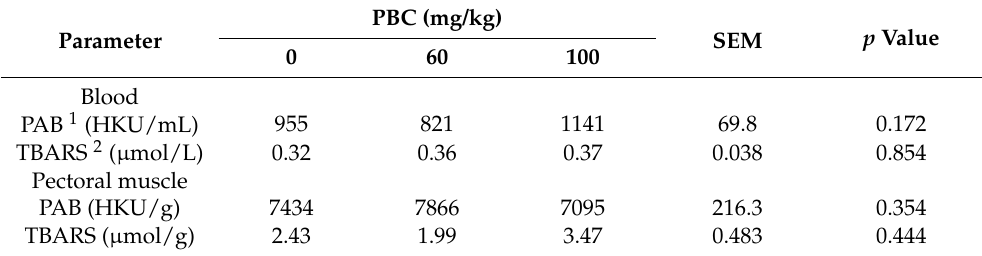
Table 4. Oxidative stress markers in chickens fed diets supplemented with 60 and 100 mg/kg